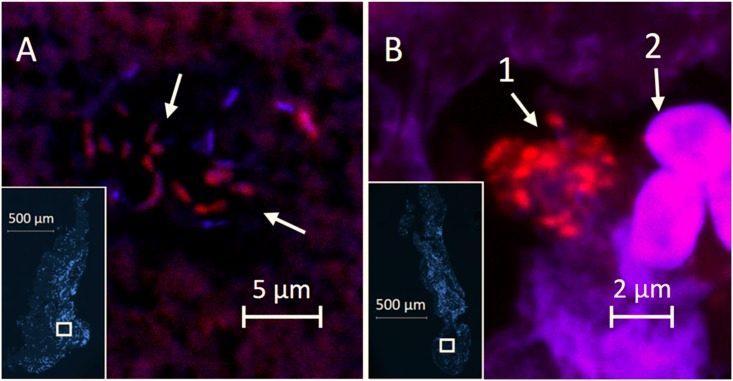
Confocal laser scanning microscopy images with PNA-FISH showing microcolonies of bacteria detected in coronary thrombi.Confocal laser scanning microscopy images with Peptide nucleic acid fluorescence in situ hybridization (PNA-FISH) of aspirated coronary thrombi from patients with STEMI. A: Magnified image of hybridization with a TexasRed (TXR) conjugated universal 16S rRNA probe and 4',6-diamidino-2-phenylindole (DAPI) counterstaining showing microcolonies of rod-shaped bacteria (arrows). Miniature overview with DAPI counterstaining in lower left corner with marked (□) approximate area of interest. B: Magnified image with TexasRed (TXR) conjugated P. aeruginosa specific 16S rRNA probe and DAPI counterstaining. Miniature overview with DAPI counterstaining in lower left corner with marked (□) area of interest. Cluster of P. aeruginosa (arrow 1) and adjacent red blood cells (arrow 2). Display characteristics were adjusted to automatic Best Fit for red and blue color channels. Magnification with 63x/1.4 Oil objective.